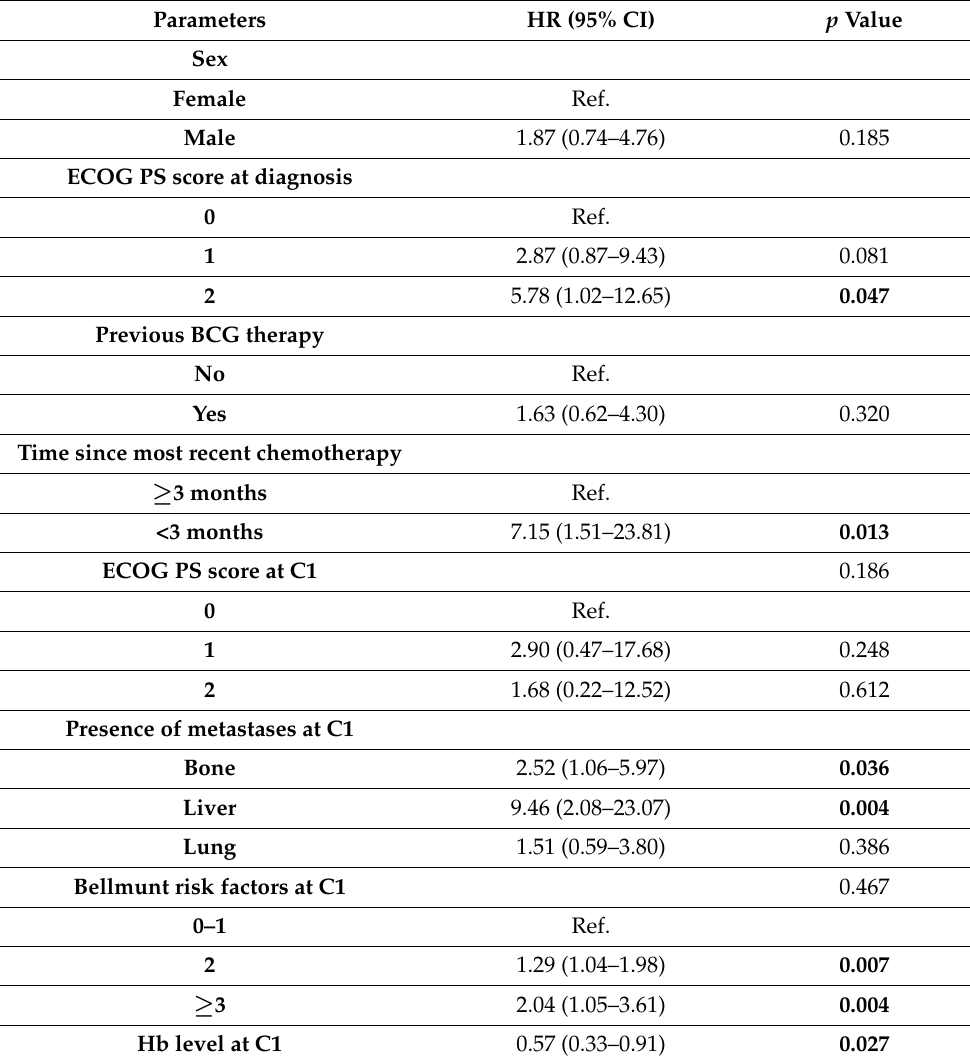
Table 1. OS status at 6 months—Multivariate